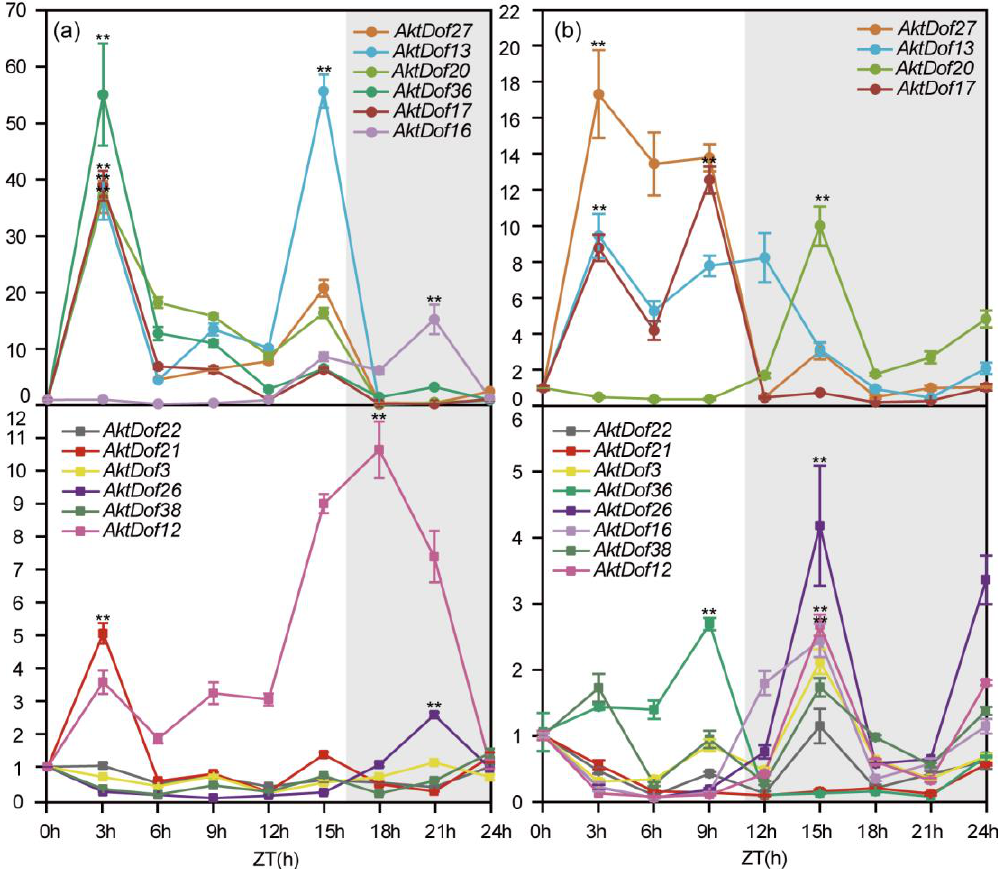
Figure 6. Expression patterns of 12 AktDofs in leaves in response to different daylengths. ( a ) The LD treatment. ( b ) The SD treatment. Time (h) is expressed as hours from dawn (ZT, zeitgeber), and the light gray represents night. The error bars represent the standard deviations of three replicates. * represents the significance between peak expression and the expression at 0 h (**, p < 0.01).